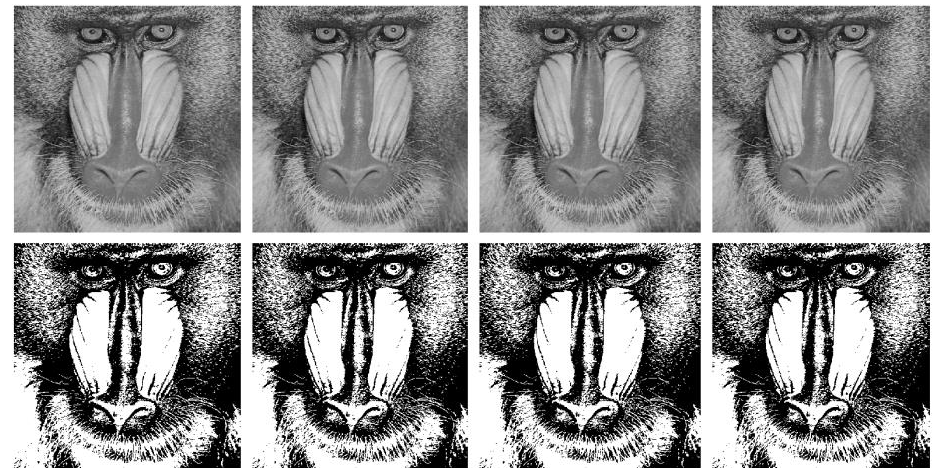
Figure 11. Visual analysis (forensics) of the baboon original image.